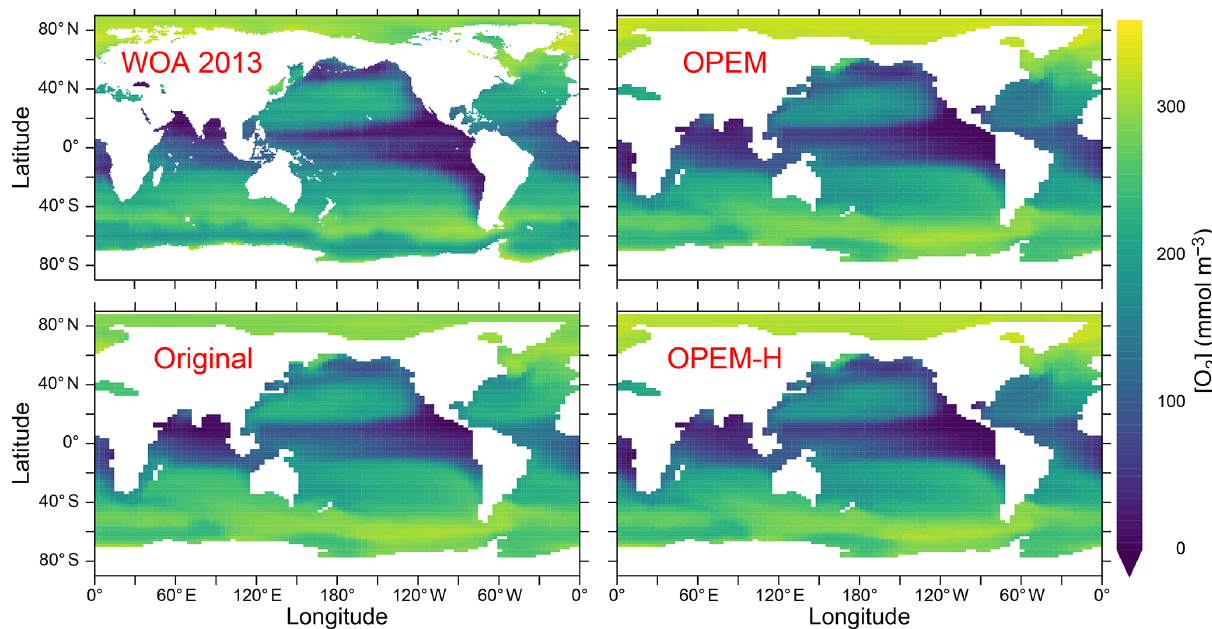
Figure 6. Annually averaged distribution of O 2 concentration at 300m in the WOA 2013 climatology and in the original, OPEM, and OPEM-H UVic